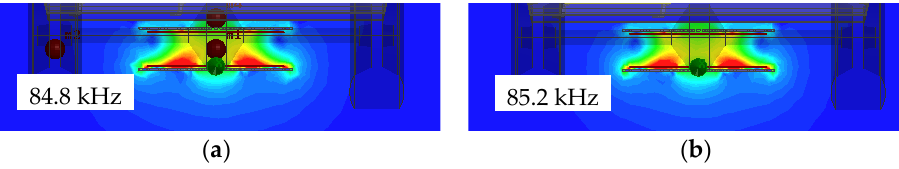
Figure 17. Current spectrum of coupling coils: ( a ) current spectrum of primary coil; ( b ) current spectrum of secondary coil.